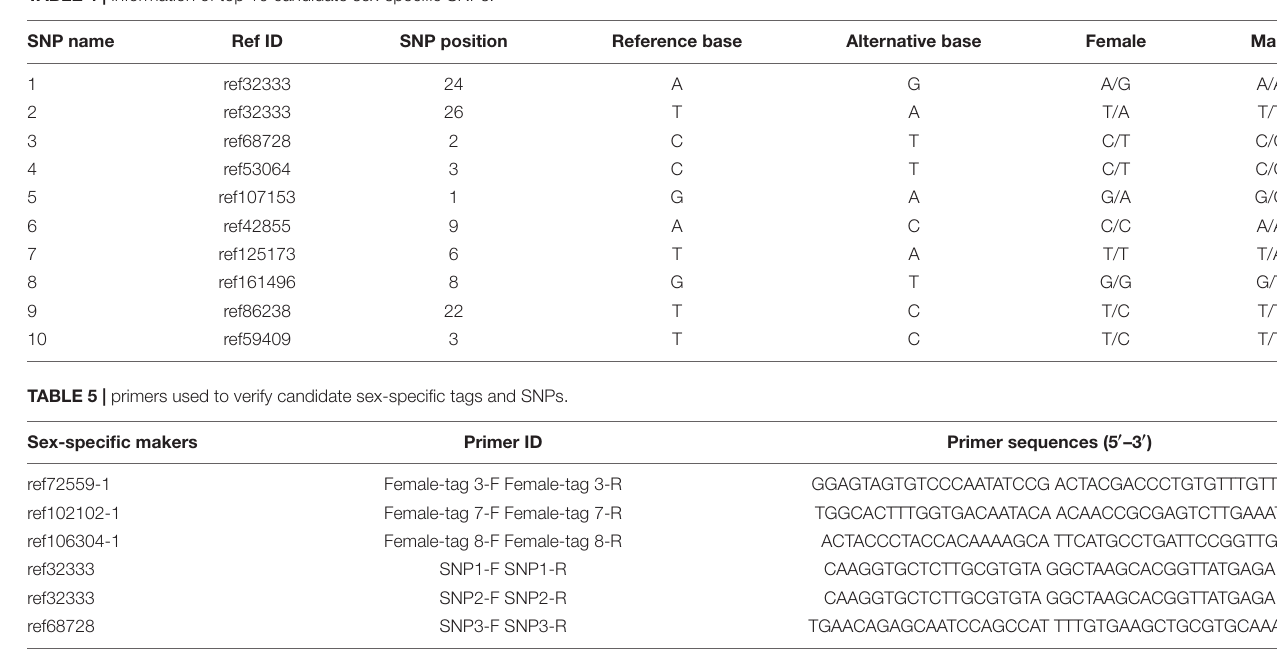
TABLE 4 | Information of top 10 candidate sex-specific SNPs.